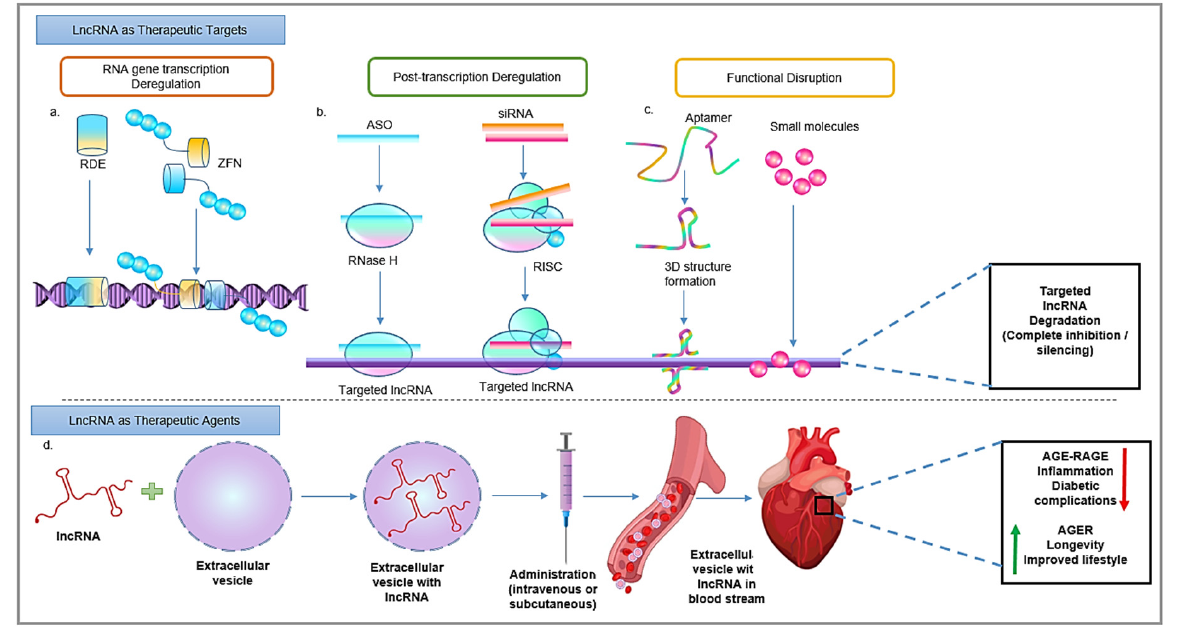
Figure 4. Potential application of lncRNAs as the future therapeutic agents or targets. LncRNAs can be targeted if they have an active role in disease progression or can be used in a therapeutic measure. Abbreviations: RDE, RNA destabilizing elements; ZFN, zinc finger nuclease; ASO, antisense oligo- nucleotide.